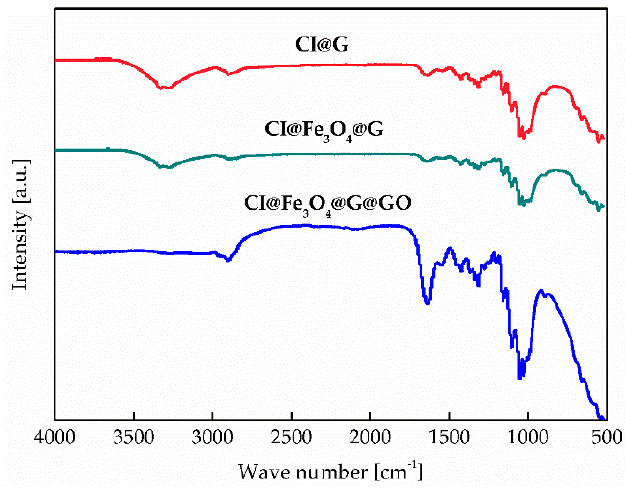
Figure 5. FT-IR spectra of CI@G, CI@Fe 3 O 4 @G, and CI@Fe 3 O 4 @G@GO particles.